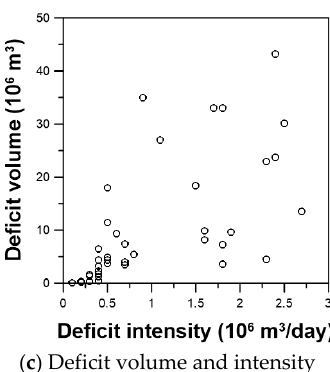
Figure 5. Scatter plots for the three pairs of components of water deficit events observed at the Namgang dam ( a ) deficit intensity and duration; ( b ) deficit volume and duration; ( c ) deficit volume and intensity.